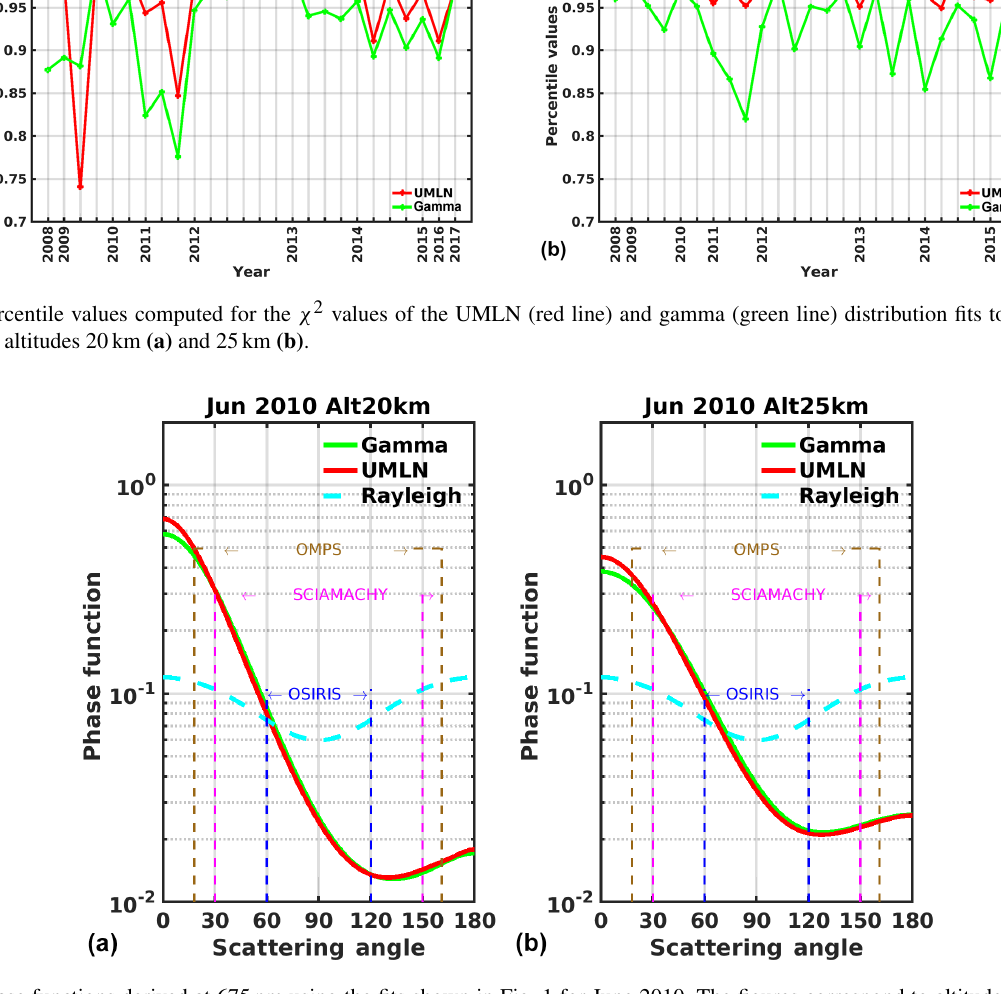
Figure 3. Phase functions derived at 675nm using the fits shown in Fig. 1 for June 2010. The figures correspond to altitude 20km (a) and to altitude 25km (b) . Also shown is the range of scattering angles for which aerosol extinctions are retrieved for OMPS, SCIAMACHY, and OSIRIS limb scatter